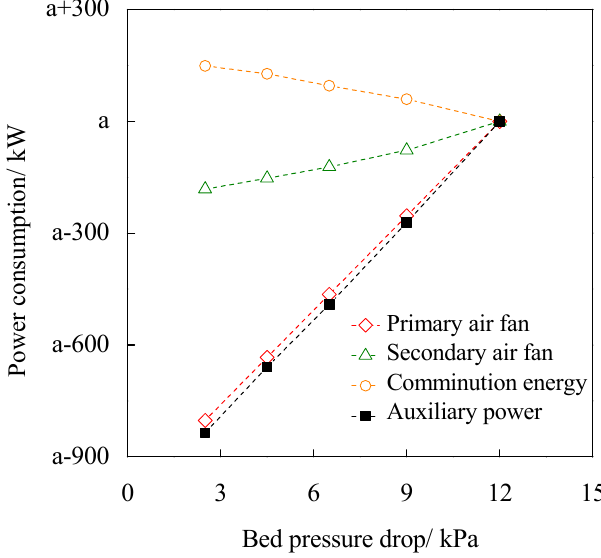
Figure 11. Change in auxiliary power consumption with the bed pressure drop.